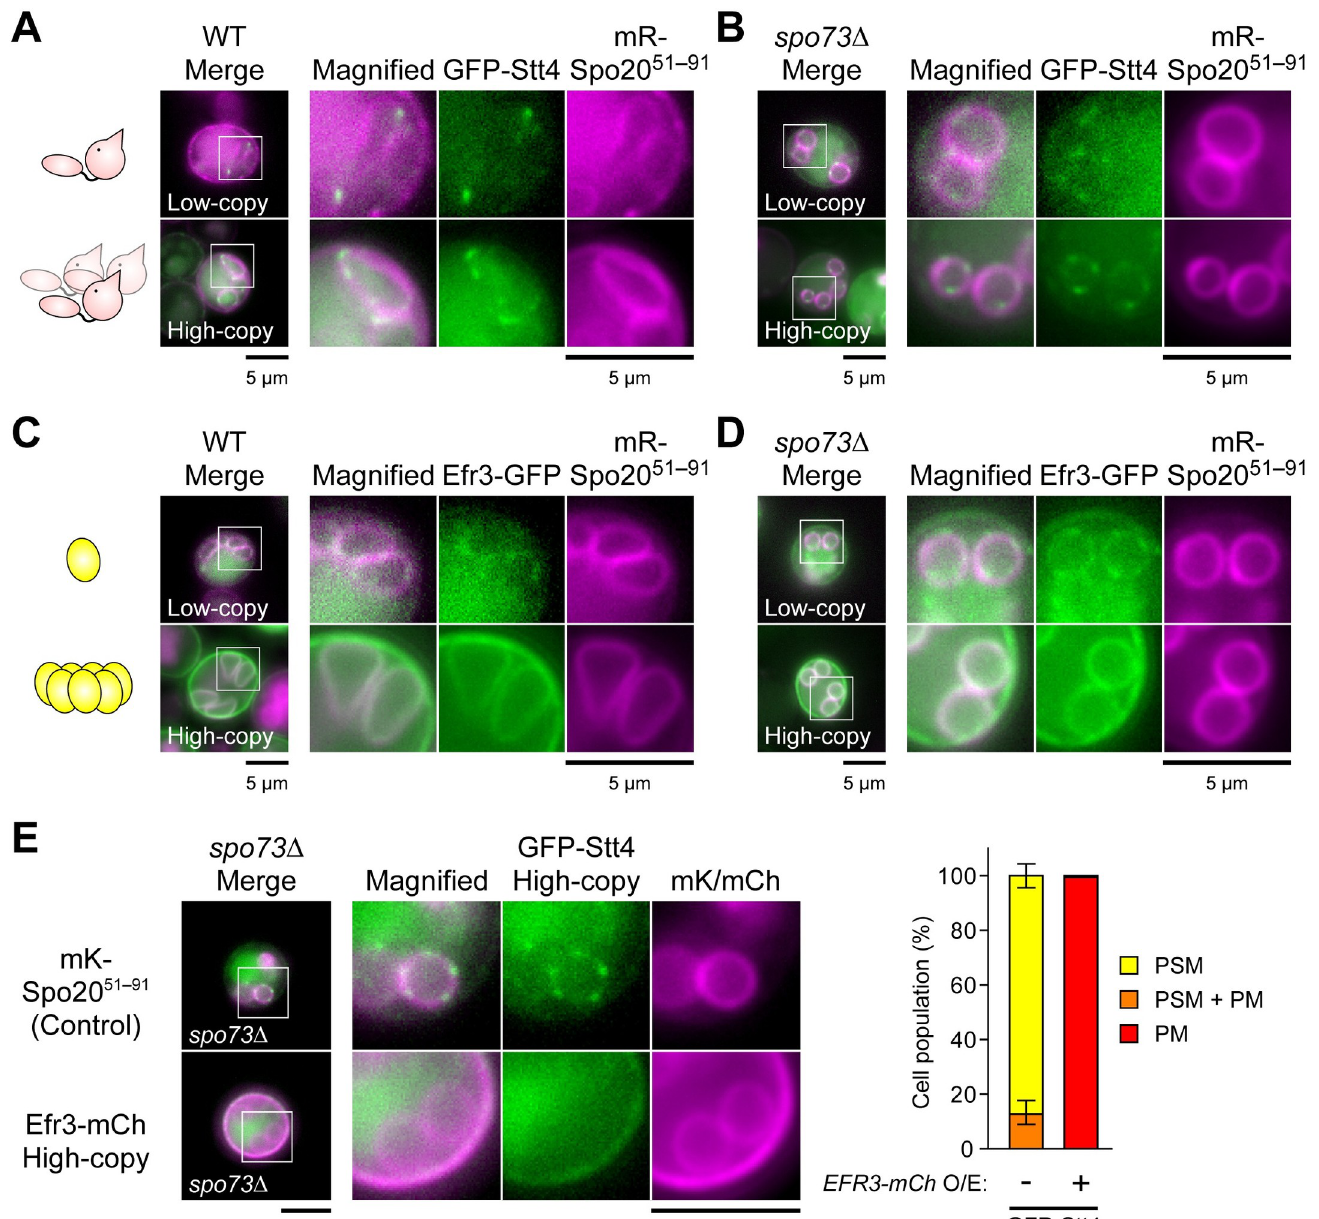
Fig 2. The PI4K complex localizes on the PSM, and suppression occurs through a dominant-negative effect. (A–D) Localization of Stt4 (A and B) and Efr3 (C and D) in wild-type (AN120, A and C) or spo73 Δ (TC545, B and D) cells during PSM formation. In each panel, GFP-STT4 and EFR3-GFP were expressed from low- copy (upper) or high-copy vector (lower). mR, mRFP. mR-Spo20 51–91 , a PSM marker. (E) Assessment of localization of overproduced GFP-Stt4 in spo73 Δ (TC545) cells producing mKate2-Spo20 51–91 (control), or overproducing Efr3-mCherry during PSM formation. Left: Representative images. Right: Percentage of cells in which GFP-Stt4 localized only on the PSM (PSM), both on the PSM and PM (PSM + PM), or only on the PM (PM). Twenty cells were observed in three independent colonies of each strain harboring indicated plasmids (for a total of > 60 cells). The bar graph shows mean ± SEM of the percentage of cells (N = 3). mK, mKate2. mCh, mCherry. Scale bar, 5 μ